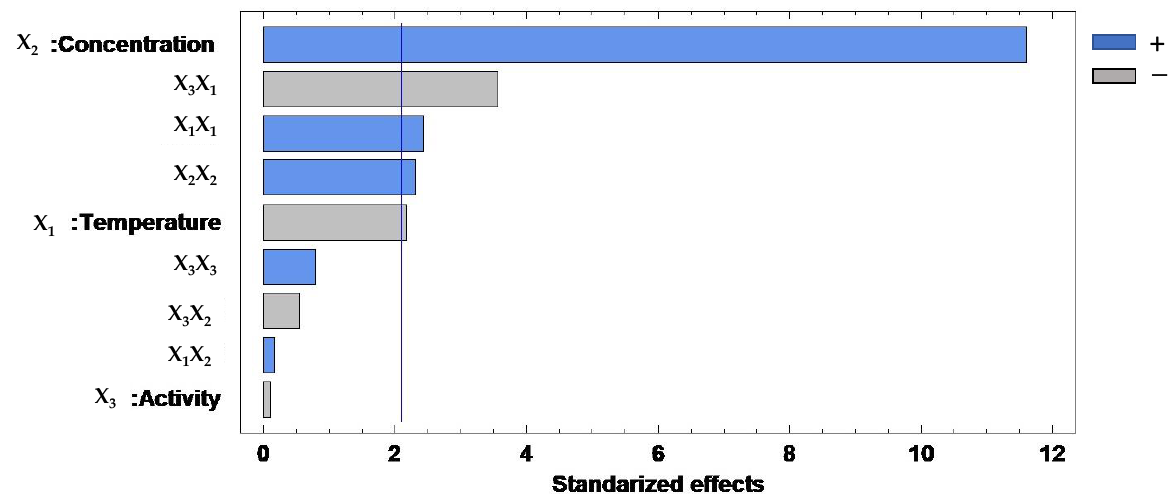
Figure 4. Pareto diagram of the standardized effects of the esterification conversion of HMF and lauric acid in acetone catalyzed by immobilized TL lipase, where x 1 : temperature; x 2 : concentration of HMF; x 3 : activity of biocatalyst.